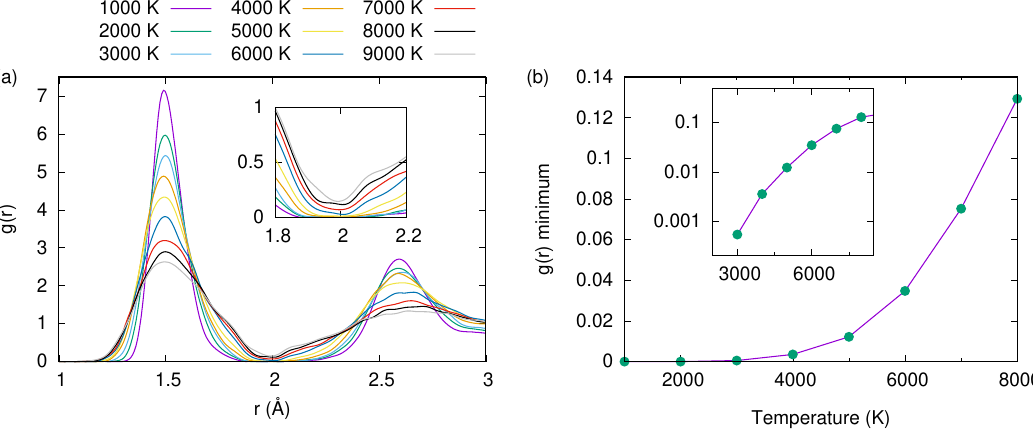
Figure 1. ( a ) Radial distribution function, g ( r ) , as a function of temperature at 1.5 g/cc using the Tersoff potential. Inset shows the first minima around 2 Å. ( b ) Temperature-dependence of the value of g ( r ) at the first minima for the data from panel ( a ). Inset shows the same data on a logarithmic